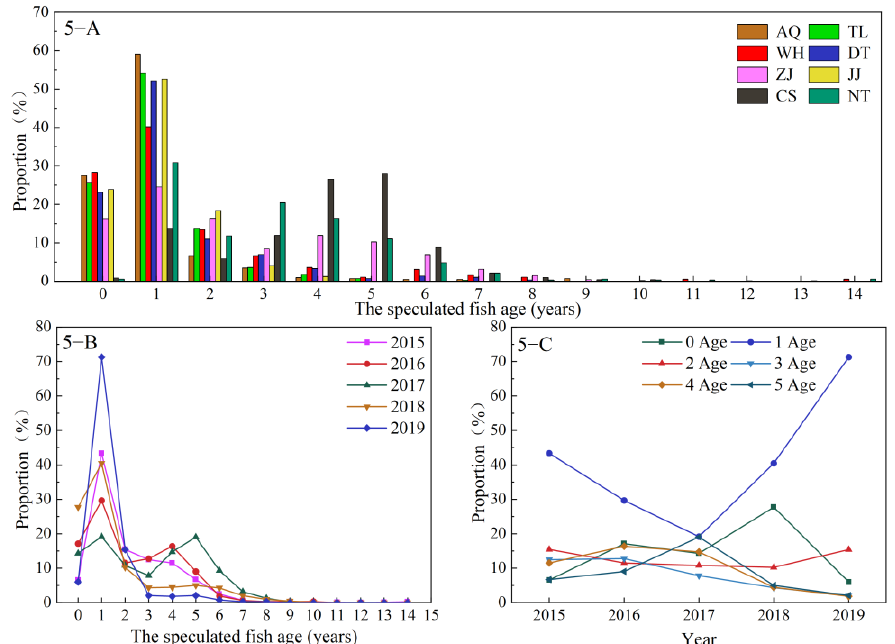
Figure 5. Proportion of Silver Carp by the speculated age. ( 5 – A ) the proportion of Silver Carp by speculated age in the eight river sections; ( 5 – B ) the proportion of Silver Carp by the speculated age in 2015-2019; ( 5 – C ) the proportion of Silver Carp by 0–5years-of-age in